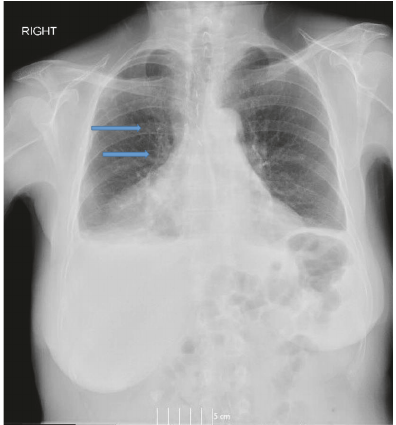
Figure 1: Chest X-ray (Posteroanterior view) showing bilateral pleural effusions with an expansile lucent lesions with septations in the right fourth and fifth ribs (arrow).